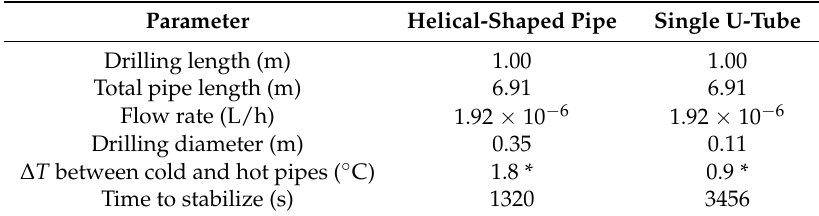
Table 4. Comparison helical-shaped pipe and single U-tube heat exchanger.